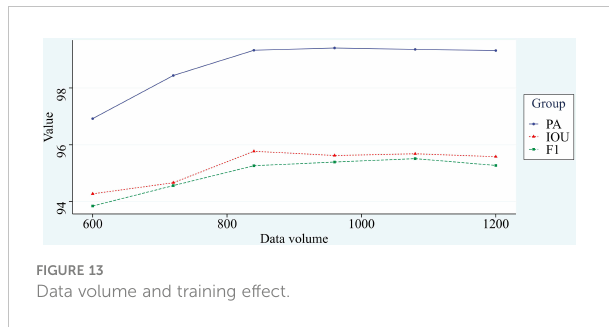
FIGURE 13 Data volume and training effect.